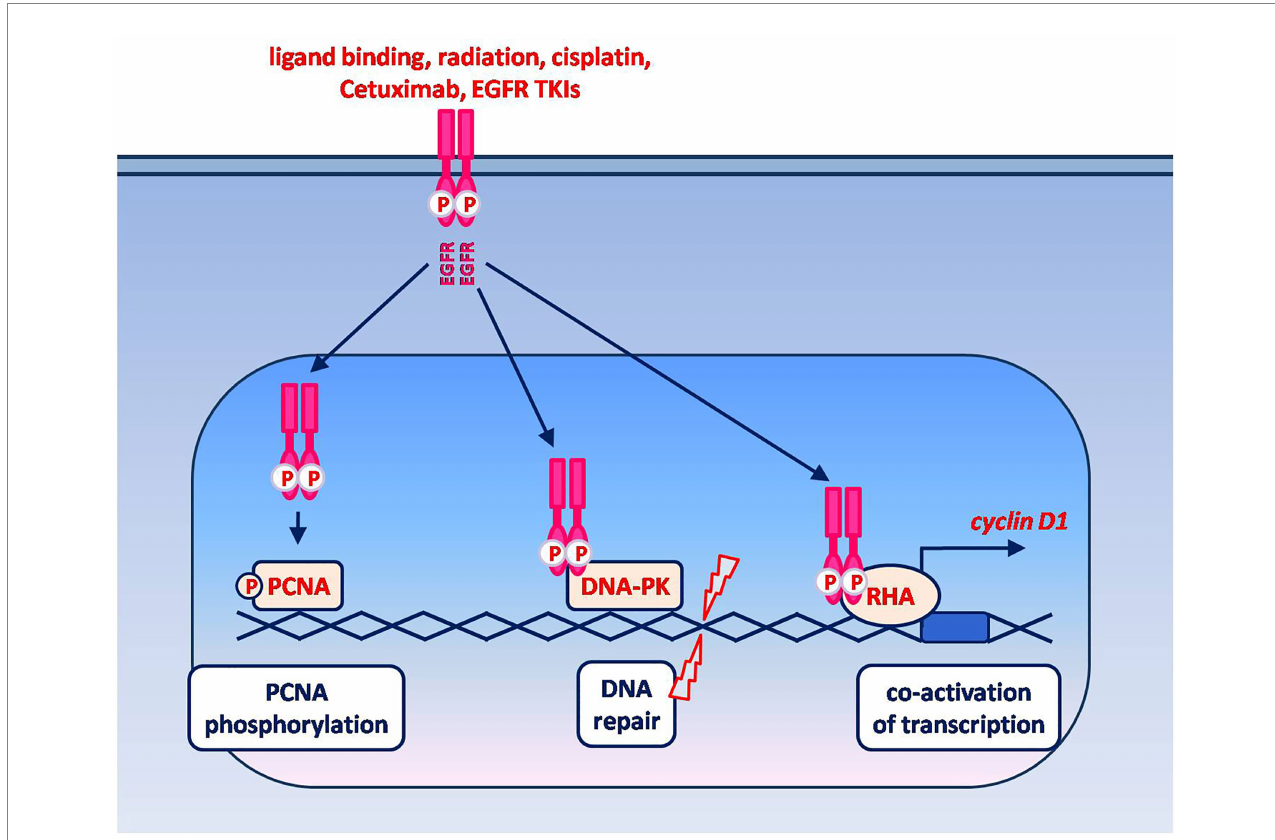
FIGURE 2 Non-canonical signaling by nuclear EGFR. EGFR nuclear translocation is known to be induced by ligand binding as well as by cell exposure to radiations, drugs and EGFR-targeting agents. The known oncogenic functions of nuclear EGFR include: phosphorylation and stabilization of chromatin-bound PCNA, which in turn plays an essential role in DNA replication and repair; promotion of DNA repair via protein–protein interaction with the DNA-dependent protein kinase (DNA-PK); co-activation of transcription via the interaction with different transcriptional regulators. The interaction between nuclear EGFR and RNA helicase A (RHA) leads to an enhanced expression of cyclin D1. Among the other genes whose expression is enhanced by nuclear EGFR, in association with various transcription factors, are those encoding for c-Myc, B-Myb, Aurora Kinase A and thymidylate